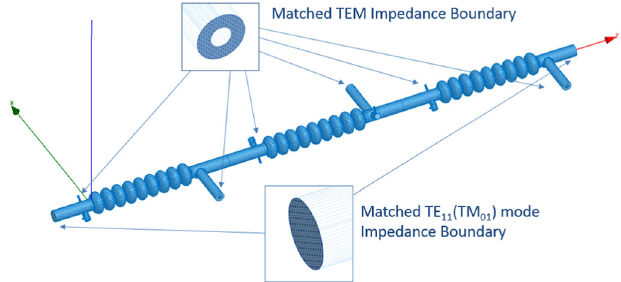
FIG. 3. ANSYS HFSS model for the eigenmode analysis of the chain of three 3.9 GHz